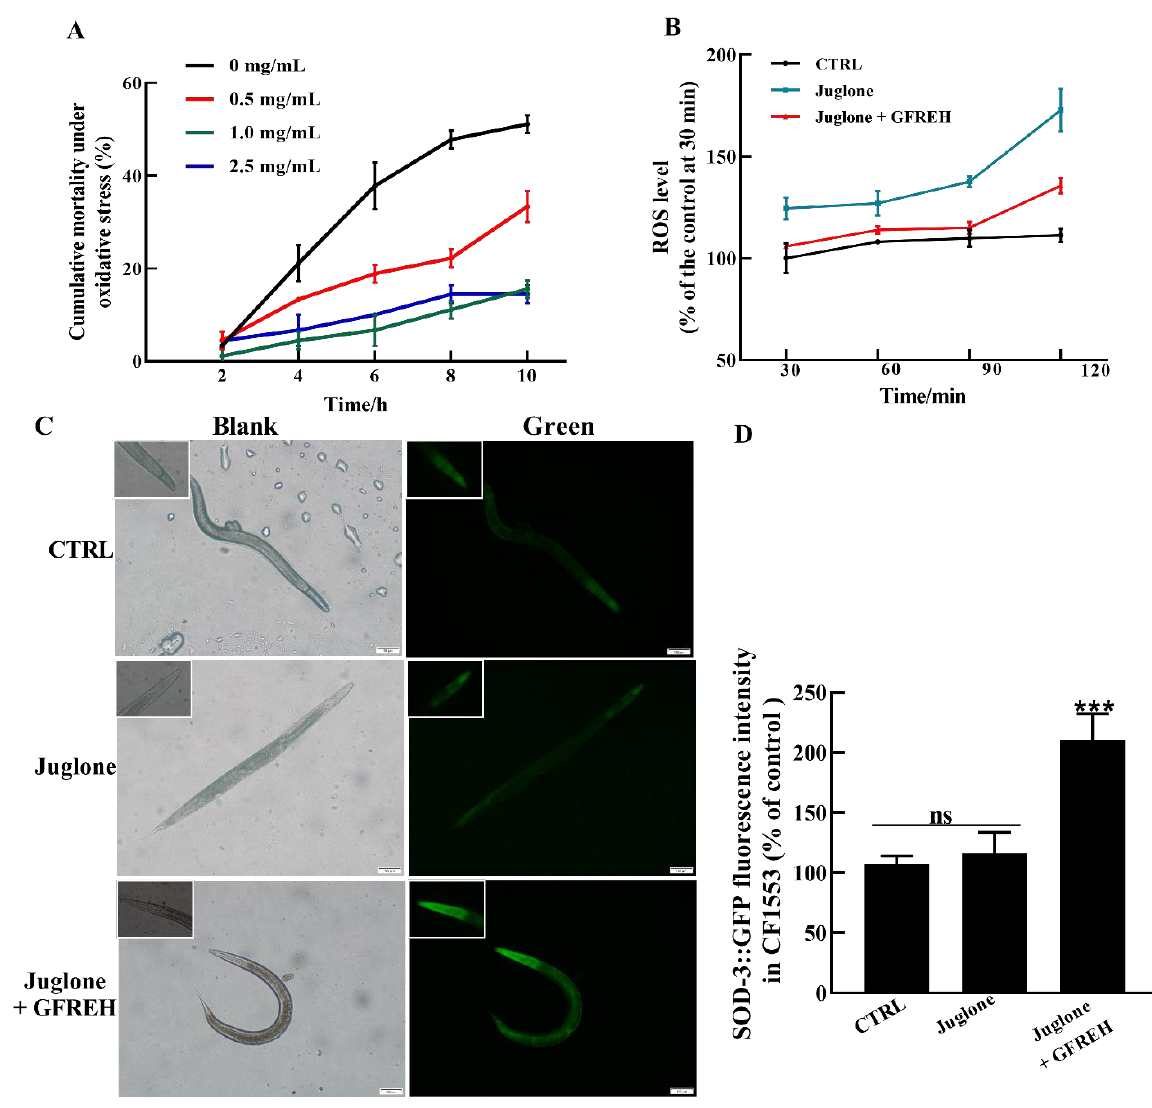
Figure 8. The protective effect of GFREH on C. elegans under stress conditions. ( A ) Different concentrations of GFREH reduced the cumulative mortality of C. elegans under oxidative stress, and the optimal concentration was 1 mg/mL, (n = 30). ( B ) GFREH reduced the ROS level in C. elegans , (n = 30). ( C ) The picture of C. elegans imaged by fluorescence microscopy. ( D ) GFREH upregulated the expression of SOD- 3 in nematodes, (n = 30). Scale bar is 100 μm. The data in A, B , and D are presented as the mean value ± SD. *** p < 0.001 vs. juglone group. CTRL: untreated worms, Juglone: